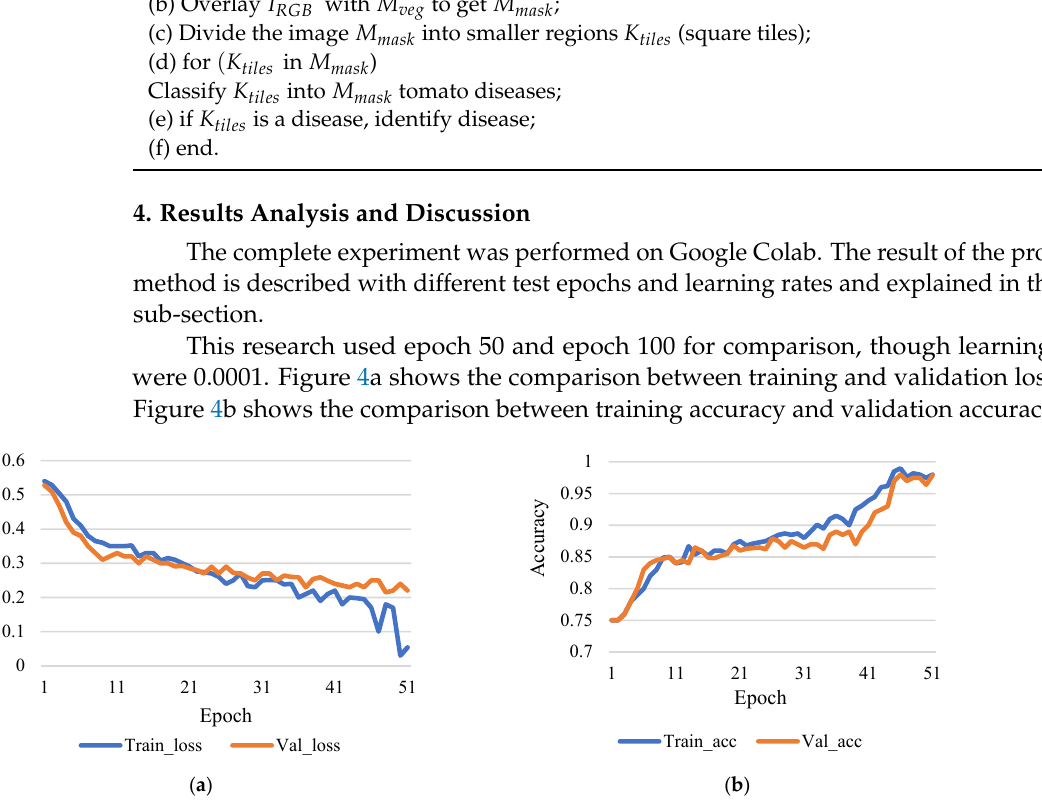
( b ) Figure 6. ( a ) Training loss vs validation loss (rate of learning 0.001 and epoch 50). ( b ) Training accuracy vs validation accuracy (rate of learning 0.001 and epoch 50). Figure 7a shows the comparison between training loss and validation loss, and Figure 7b shows training accuracy and validation accuracy. According to Figure 7b, the accurate rate of 98.42% is indicated by step 50 and a learning rate of 0.001. Furthermore, Figure 8a shows the comparison between training loss and validation loss, and Figure 8b